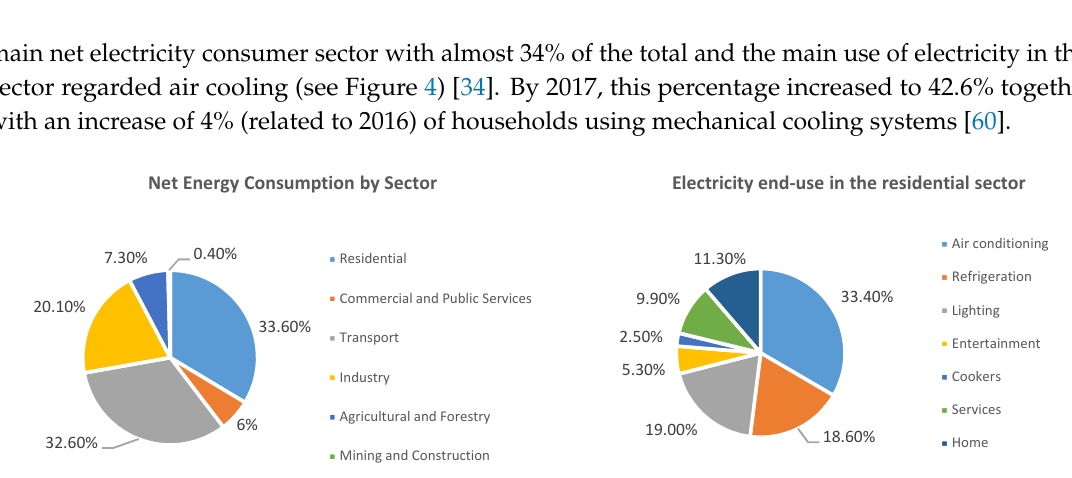
Figure 4. Net Energy consumption by sector and Electricity end use in the residential sector [34,38].